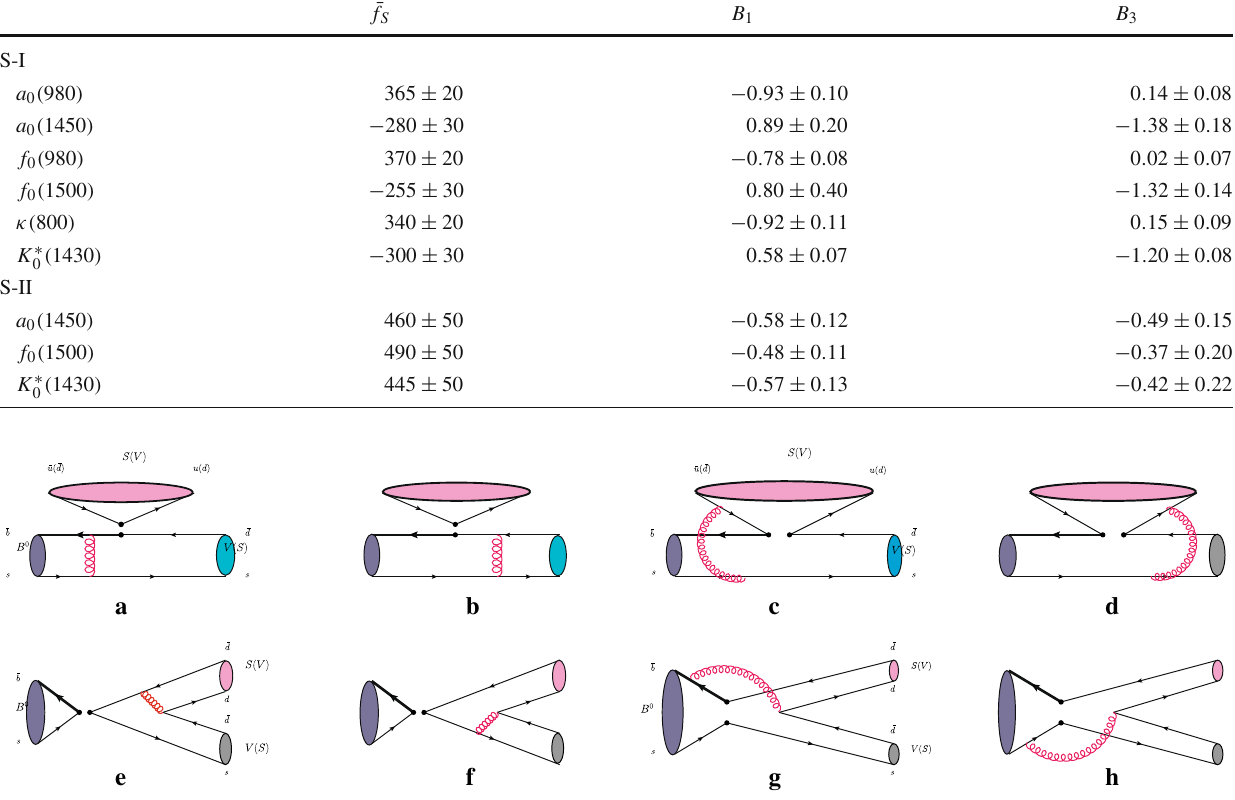
Fig. 1 Leading order Feynman diagrams contributing to the B s → V S decays in PQCD